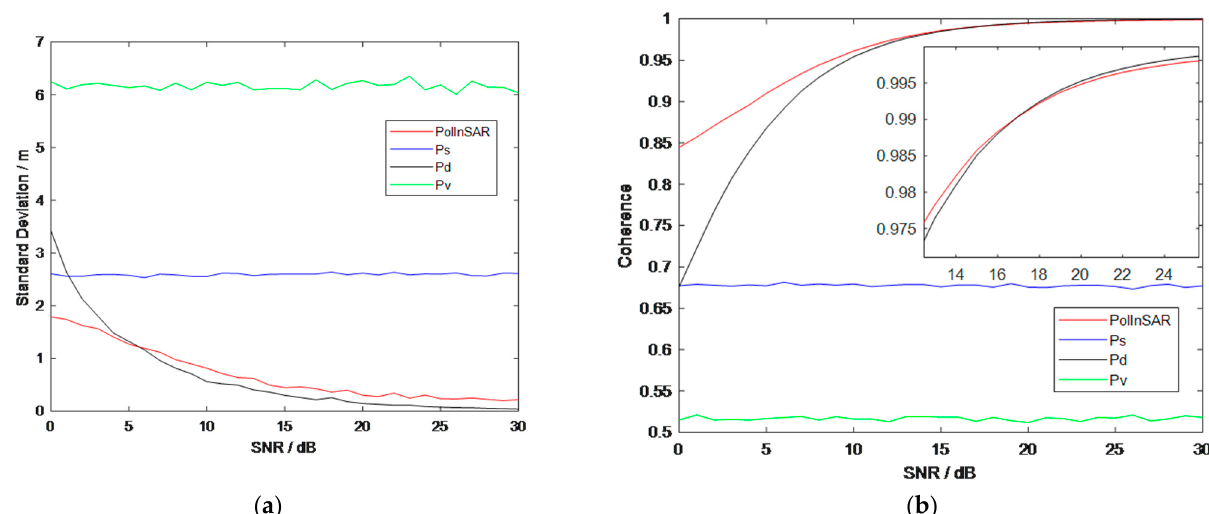
Figure 15. Simulation results in artificial target area. ( a ) Standard deviation of height. ( b ) Coherence. It shows that the height obtained by PolInSAR is more stable when the SNR of the main mechanism is lower than 5 dB and that PolInSAR has a greater coherence when the SNR of the main mechanism is lower than 18 dB.